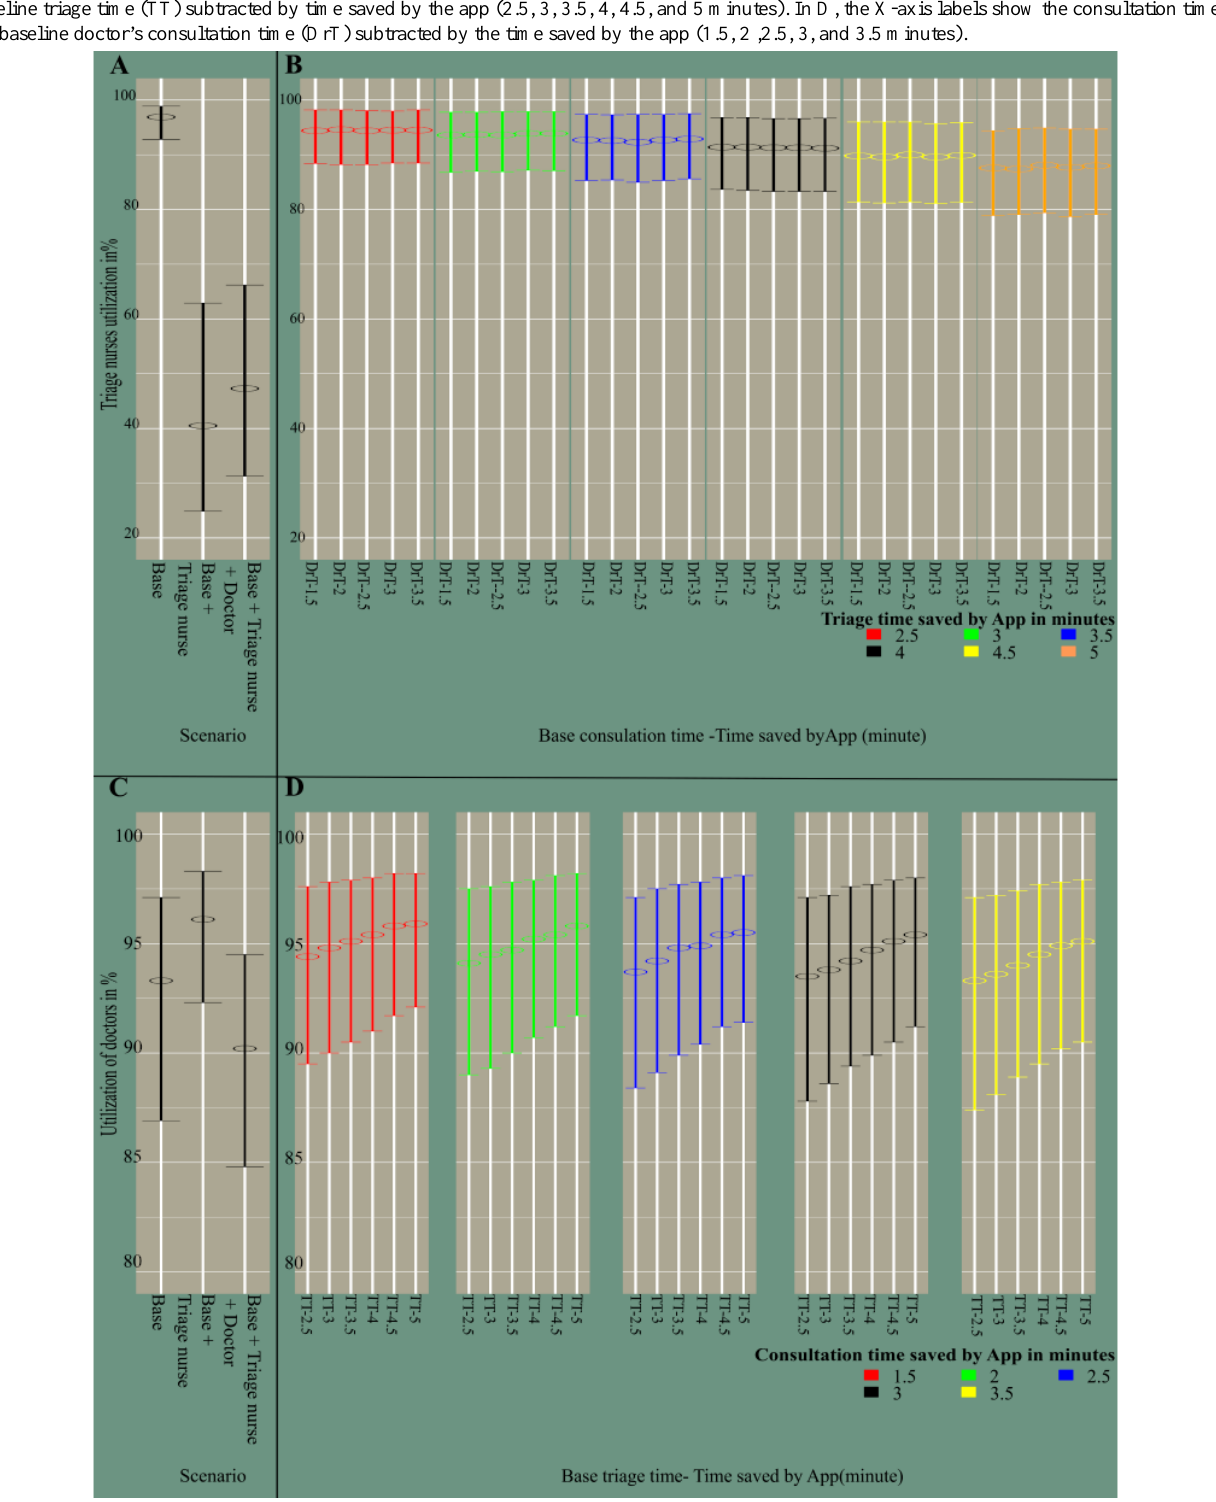
Figure 2. Utilization of triage nurses (A and B) and doctors (C and D) in percentage. A and C represent the idle time of the staff in scenarios where no app is used, which is the baseline case setting, and in scenarios with extra staff. B and D indicate the idle time of triage nurses and doctors in 30 different scenarios combining different time savings by the app in the triage and consultation processes. In B, the X-axis labels show triage time as the baseline triage time (TT) subtracted by time saved by the app (2.5, 3, 3.5, 4, 4.5, and 5 minutes). In D, the X-axis labels show the consultation time